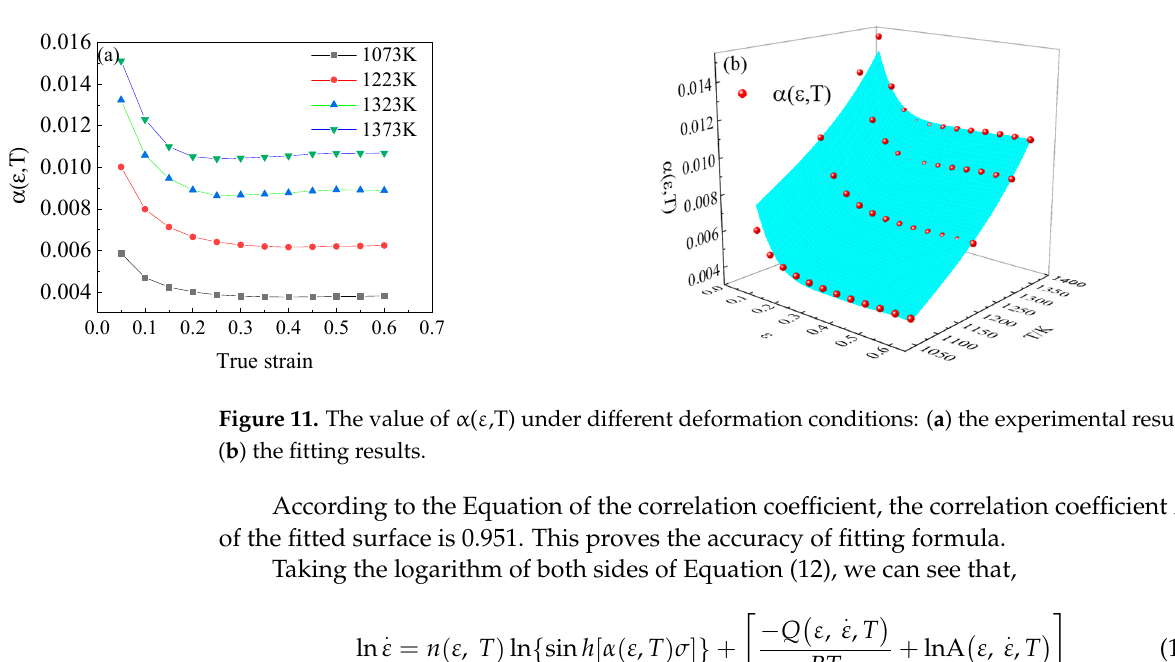
Figure 12. The value of n ( ε , T ) under different deformation conditions: ( a ) the experimental results, ( b ) the fitting results.